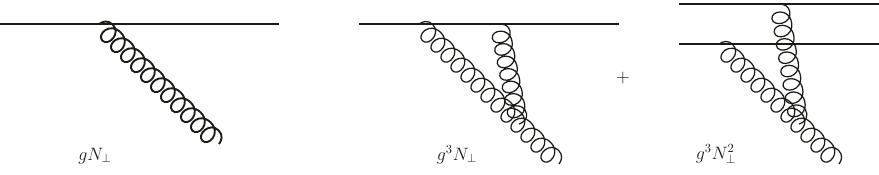
Figure 1 . Schematic diagrams showing perturbative corrections to small- x gluon distribution at order g and order g 3 . Saturation correction at order g 3 only takes into account the type of diagrams which are parametrically proportional to g 3 N 2 . ⊥